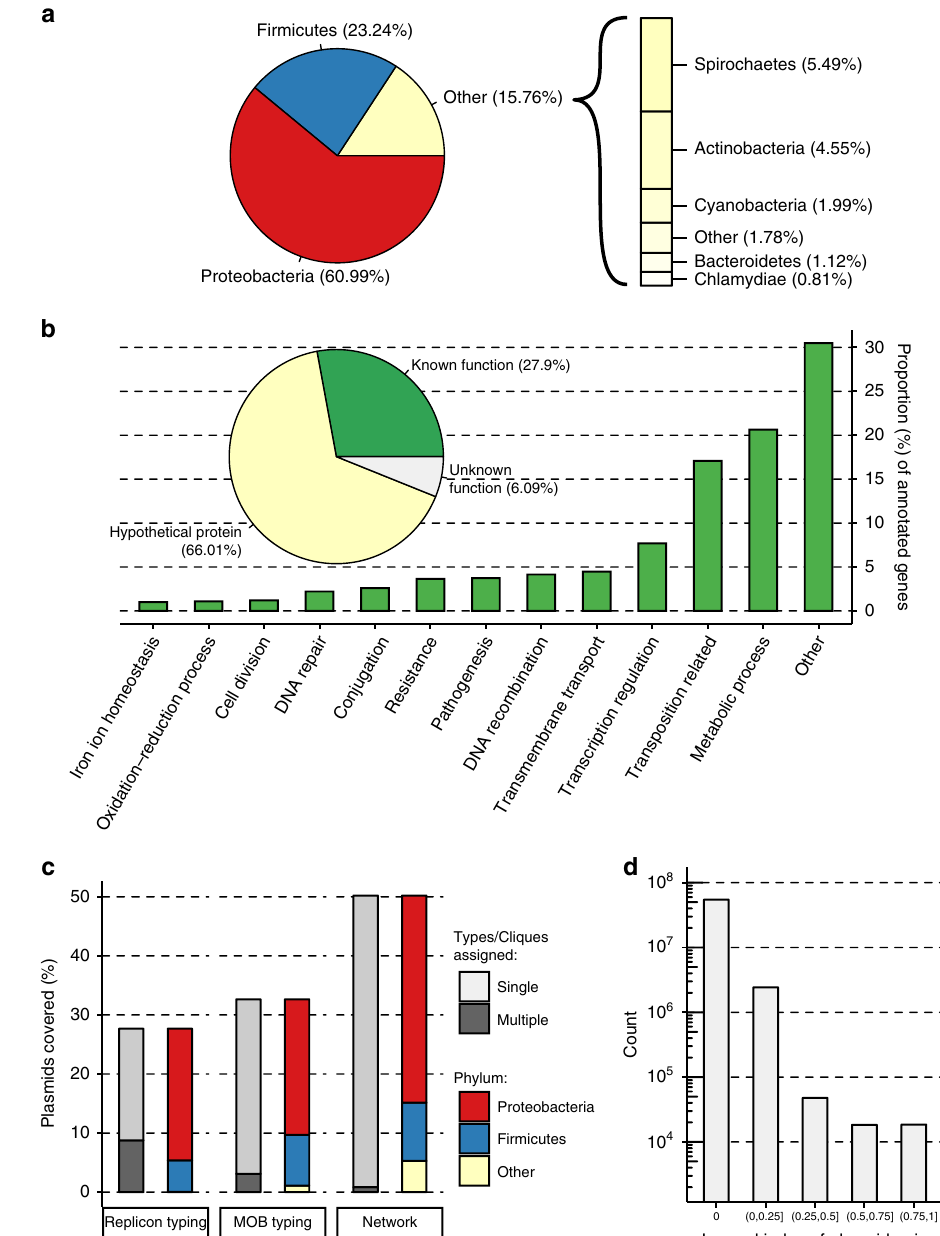
Fig. 1 Summary of the dataset of complete bacterial plasmids. a The distribution of host phylum represented in the plasmid dataset. b Functional annotation of plasmid-borne genes. The pie chart shows the proportion of unique CDSs with hypothetical function as predicted by Prokka 48 , and CDSs (genes) with known/unknown biological function based on GO annotation. The bar chart provides the most common biological functions associated with plasmid-borne genes also considering the respective frequency of these genes on plasmid genomes. c The percentage of plasmids covered by the three classi fi cation methods: replicon and MOB-typing schemes, and clique assignment. d The distribution of pairwise plasmid similarities (Jaccard